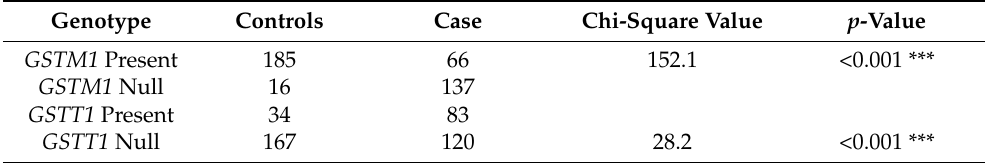
Table 1. Distribution of the presence or absence of the GSTM1 and GSTT1 genes among CP cases and control subjects enrolled in the present study. The p -value represents the outcome of the chi-square test calculated for each combination.